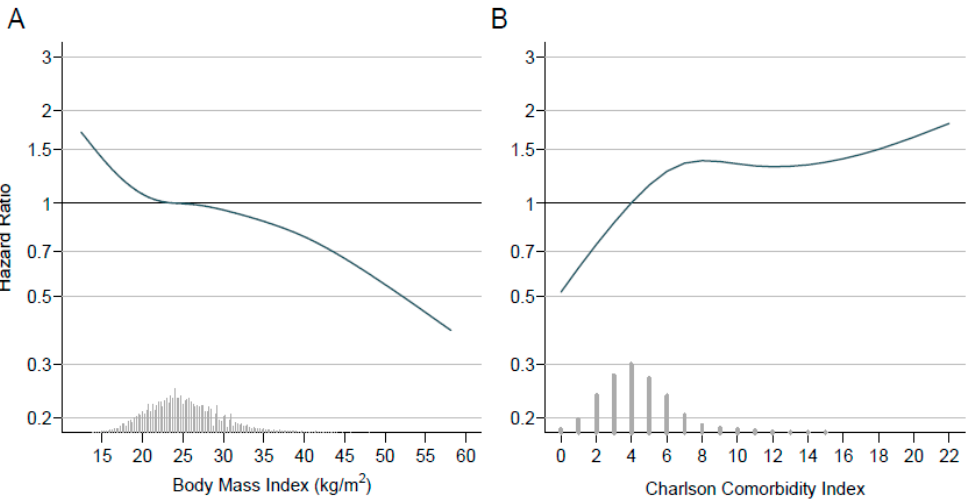
Figure 3. Unadjusted hazard ratio of body mass index ( A ) and Charlson comorbidity index ( B ). The hazard ratio (dark blue line) and 95% confidence interval (blue shaded region) are given for the whole range of observed values, relative to the mean BMI or CCI value. On the bottom of the plot, a histogram or bar chart shows the distribution of BMI or CCI values in the study.